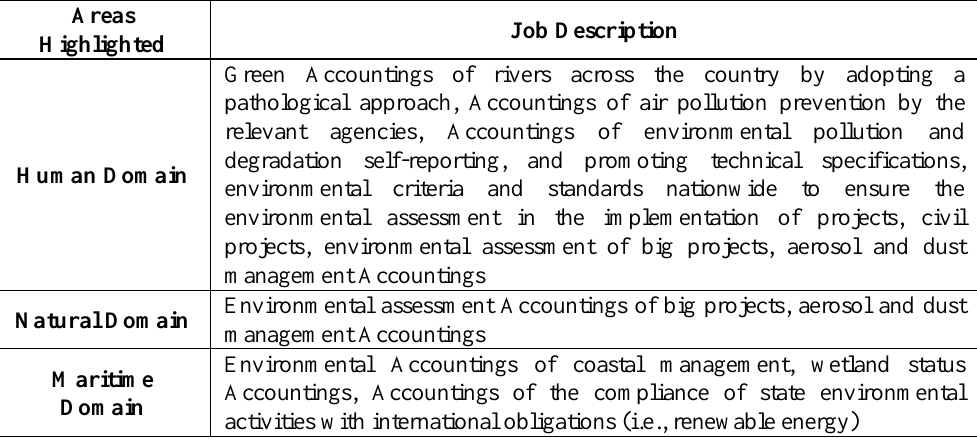
Table 1. The domains examined by Iran’s Environmental Accounting (Mirnajafi, 2012) Areas Job Description Highlighted Green Accountings of rivers across the country by adopting a pathological approach, Accountings of air pollution prevention by the relevant Human Domain